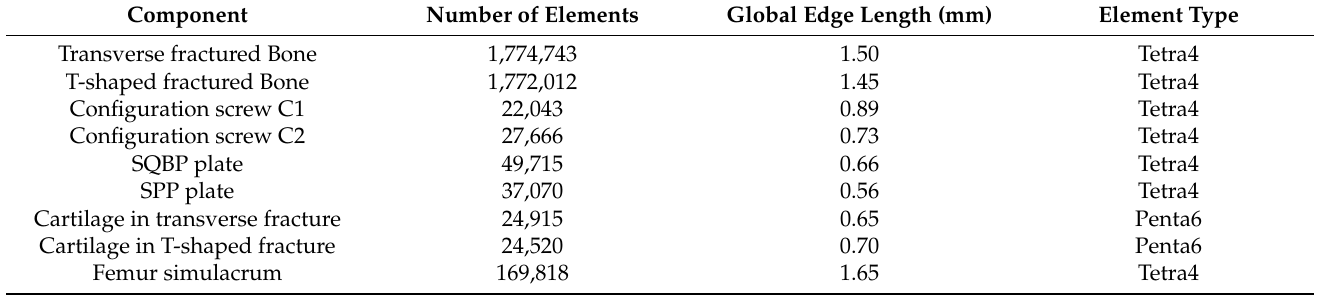
Table 2. Number of elements, elements global edge length and element type for each models’ component.